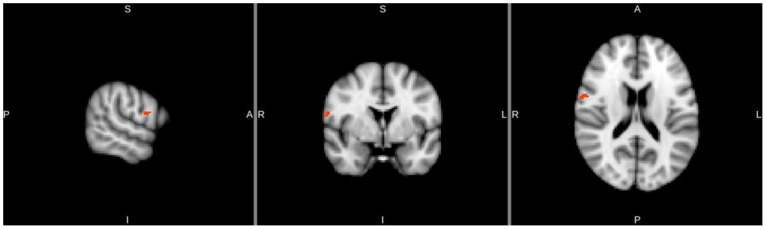
Searchlight analysis results.Classification accuracy in the right vPMC across subjects that survived FDR correction for multiple comparisons (FDR, p<.05) is displayed. Peak voxel coordinate in MNI space is (15, 64, 46).